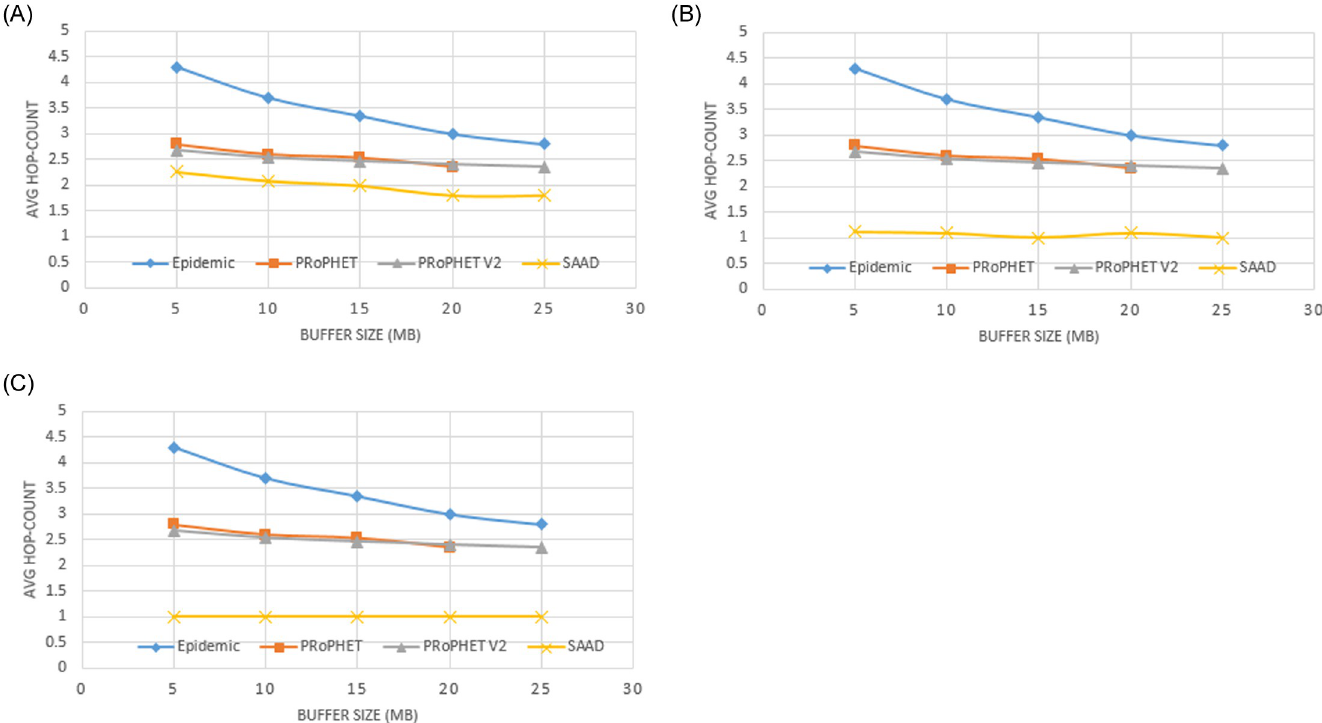
Fig 7. A. Average Hop-count with different buffer capacity and DC (threshold = 0). B. Average Hop-count with different buffer capacity and DC (threshold = 2). C. Average Hop-count with different buffer capacity and DC (threshold = 4).